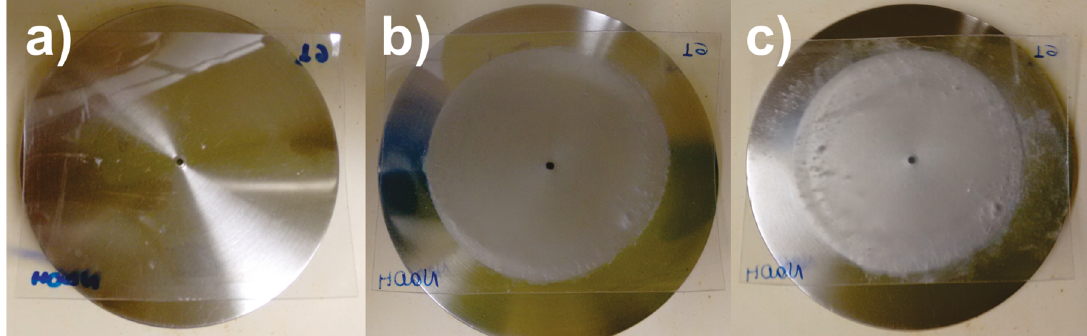
Figure 3. PET samples exposure to NaOH at (a) time zero, (b) 30 days and (c) 60 days. The metal support was used to better visualize PET changes.